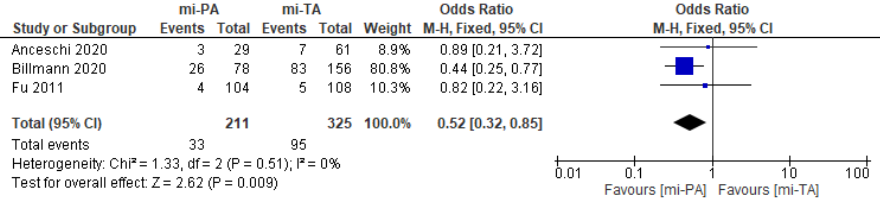
( e ) Forest plot representing analysis of overall complication.